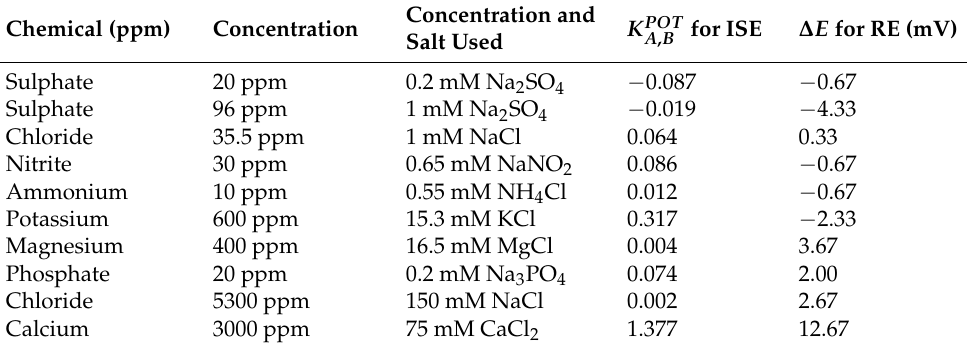
Table 2. Nickolsy–Eisenman coefficients for ions found in soil.